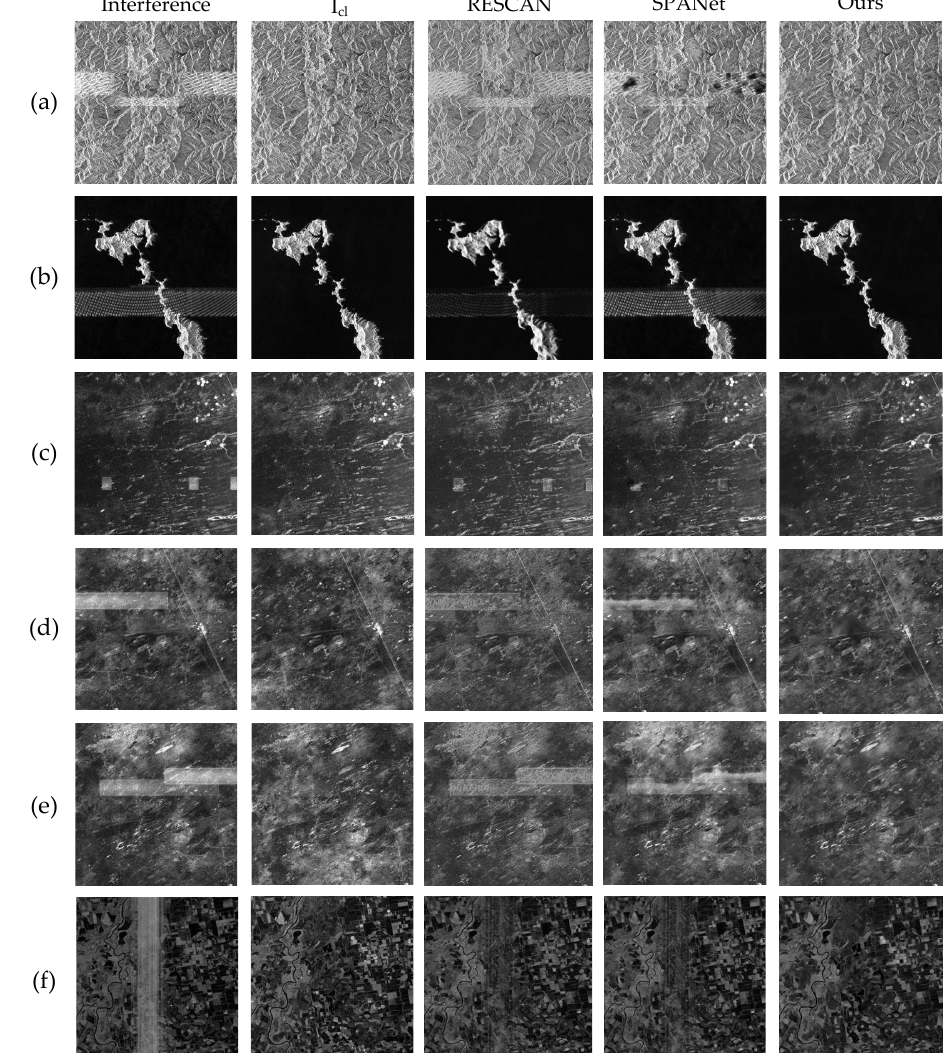
Figure 9. Visual results of measured data. The first column gives the interfered SAR images and the second column gives the corresponding ground truth. The third to fifth columns give the results of the different methods. Additionally, ( a – f ) indicate the different scenes from Figure 8. In addition, ( a , c ) the enlarged regions of interest are shown in Figures 10 and 11.